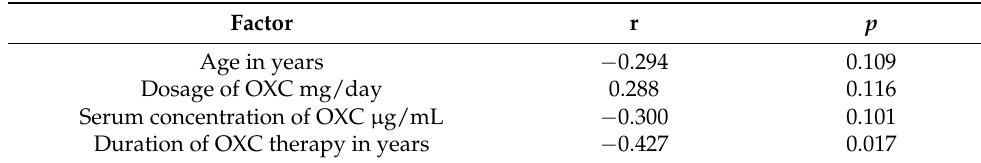
Table 3. Correlations between clinical factors and serum sodium concentration among OXC- treated patients (N = 31).